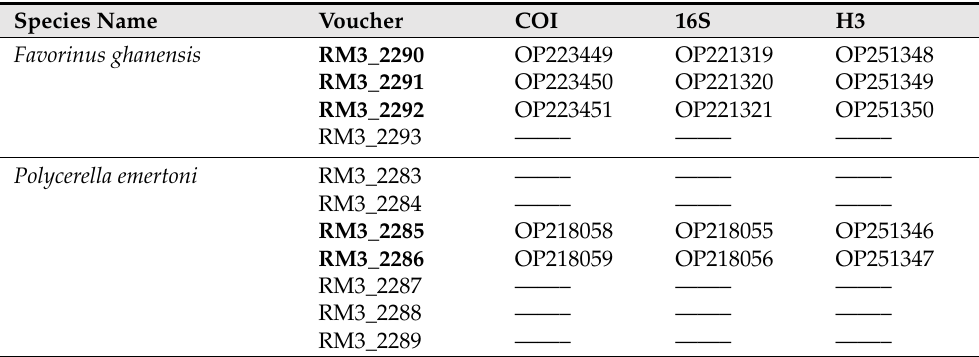
Table 1. Species names and voucher codes, as well as COI, 16S, and H3 GenBank accession numbers, of the specimens collected from the marina of Fezzano (Ligurian Sea) are listed. In bold are the specimens that were molecularly